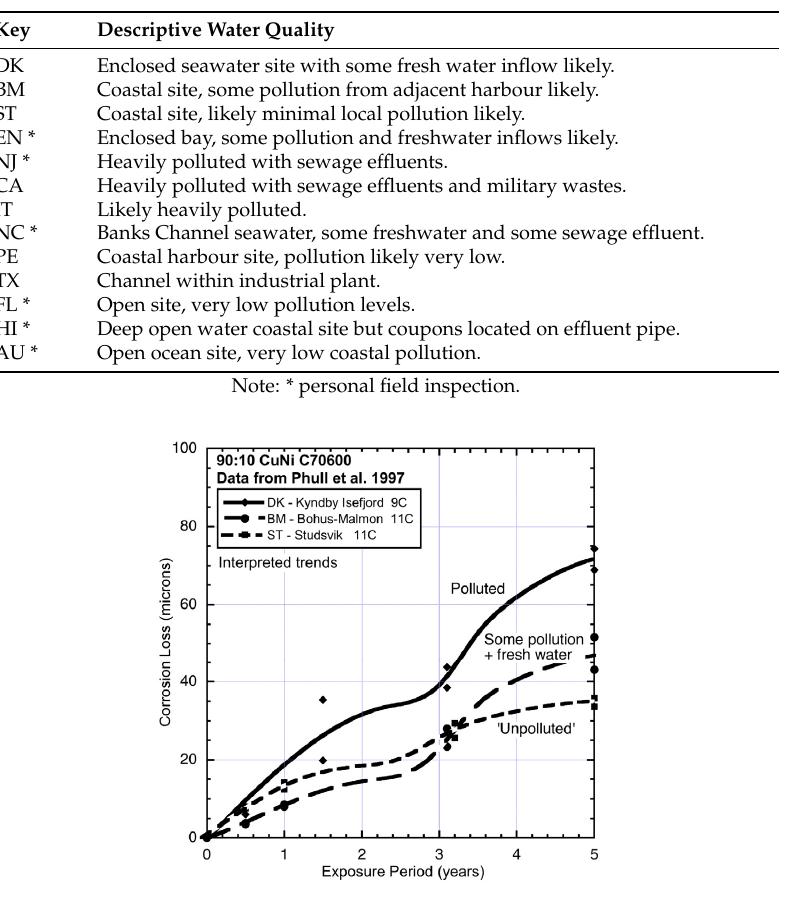
Figure 3. Data and interpreted trends for colder seawater sites DK, BM and ST.